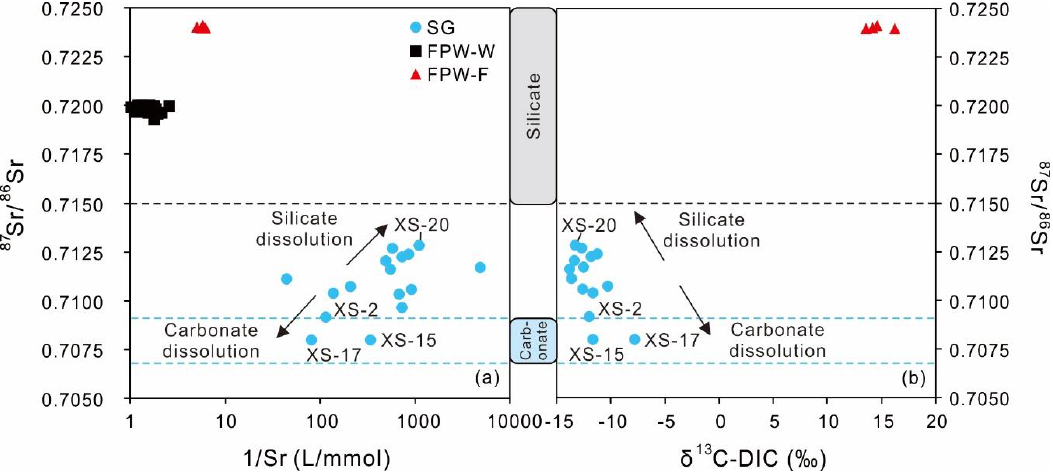
Figure 6. The diagrams of 87 Sr/ 86 Sr vs. 1/Sr (a) and 87 Sr/ 86 Sr vs. δ 13 C-DIC (b) for shallow groundwater, FPW-W, and FPW-F. The 87 Sr/ 86 Sr values from the weathering of silicate rocks were higher than 0.7150 [84–86]. The ratios of 87 Sr/ 86 Sr of carbonate rocks were in a range between 0.7068 and 0.7091